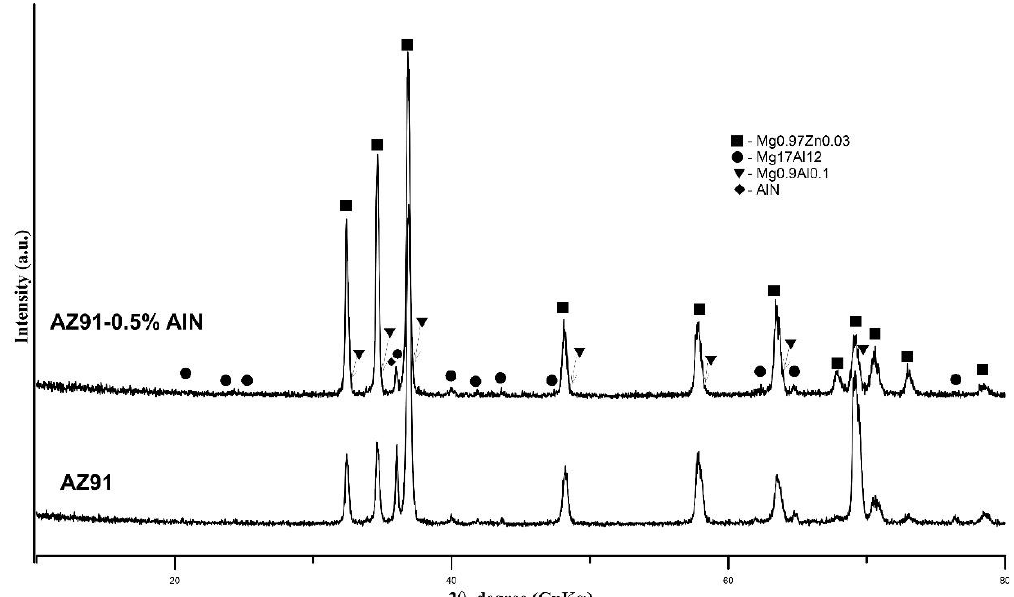
Figure 7. XRD pattern of the AZ91 magnesium alloys.